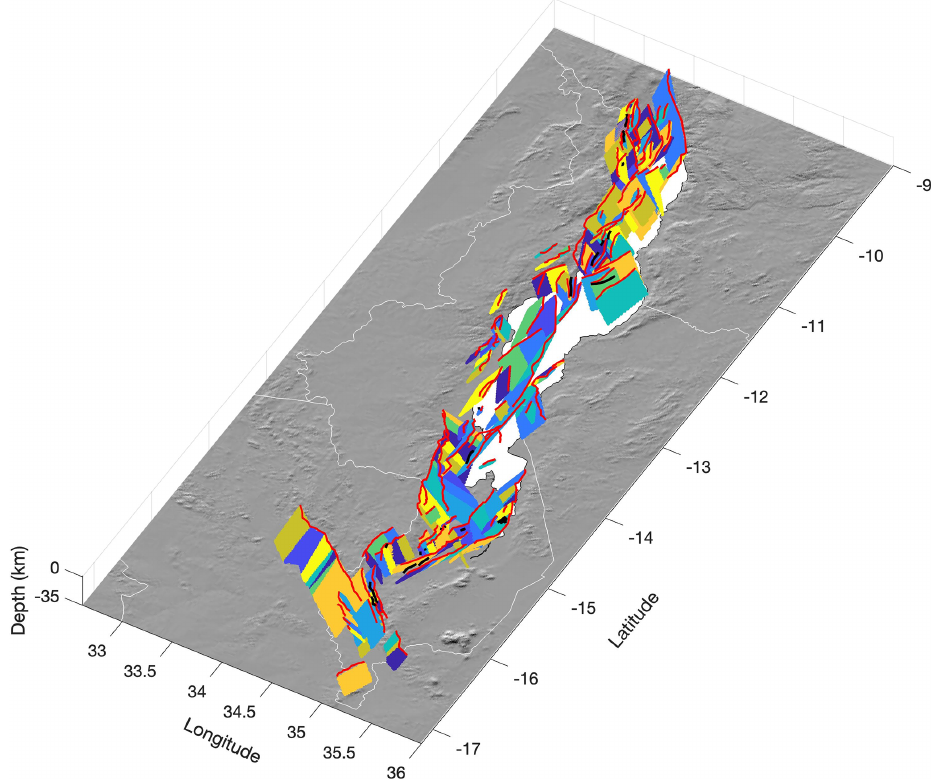
Figure 3. A 3D geometrical model of all MSSM sources. Each coloured 2D plane represents a distinct along-strike MSSM section or fault (note that colours are assigned randomly). Red and black lines are the fault traces from the Malawi Active Fault Database (MAFD) that are, and are not, included in the MSSM, respectively. Image underlain by SRTM